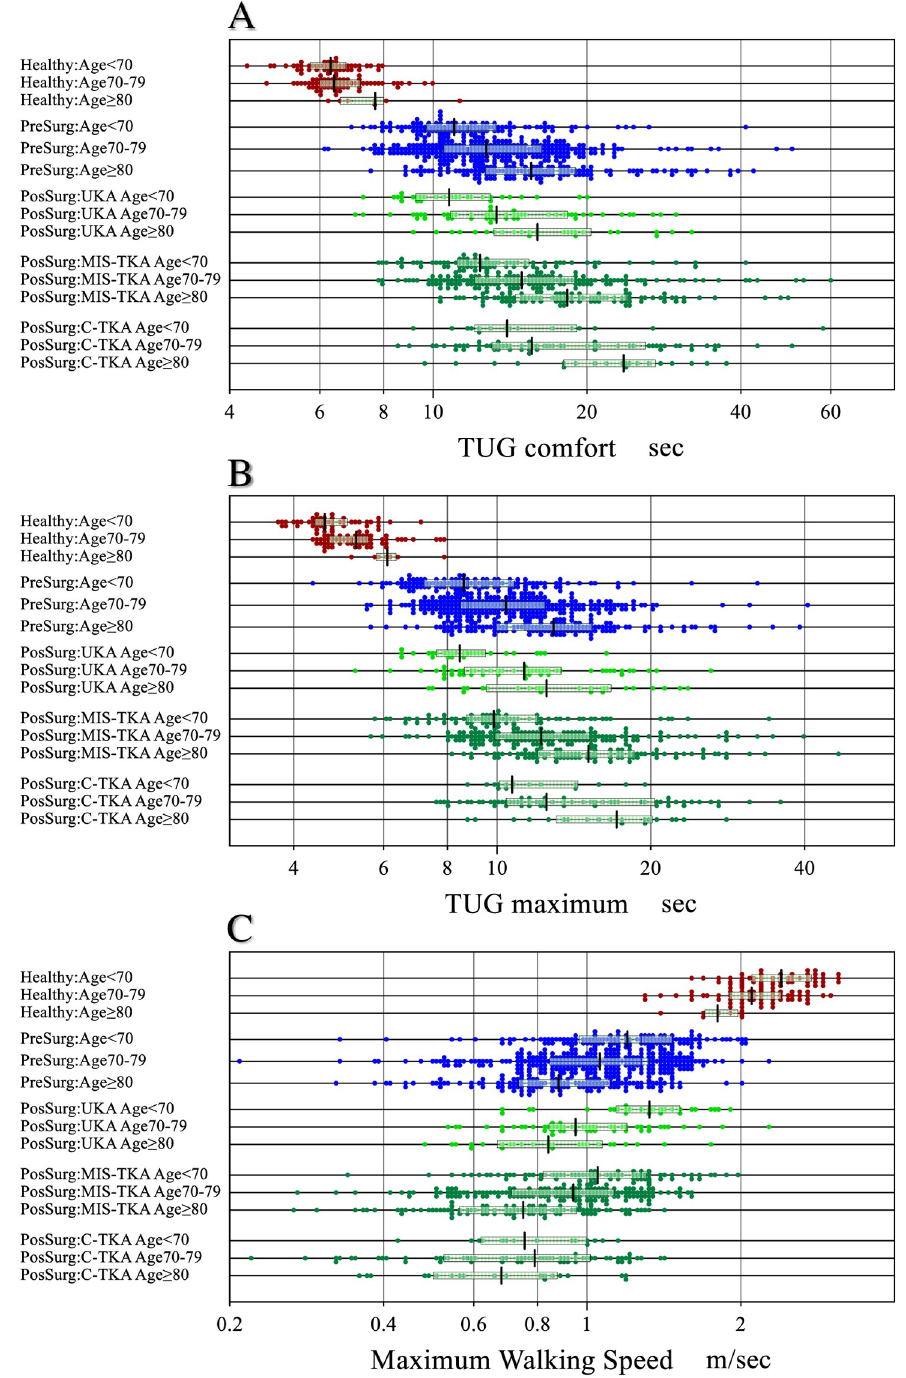
Fig 3. Comparison of TUGs and MWS partitioned by age and surgical mode. Measured results of timed up and go test (TUG) at comfortable (A) or at maximum (B) walking speed in seconds, and maximum walking speed (MWS) (C) were compared between three groups: Healthy controls and patients before and after surgery. Because of prominent age-related changes in the values, they were partitioned by age at 70 and 80 years, and for postsurgical values, also by surgical modes. The x-axis of TUG was transformed logarithmically and that of MWS was transformed to the power of 0.8 to make their distributions near Gaussian. The box and center line respectively represent the mid-50% range and median of each